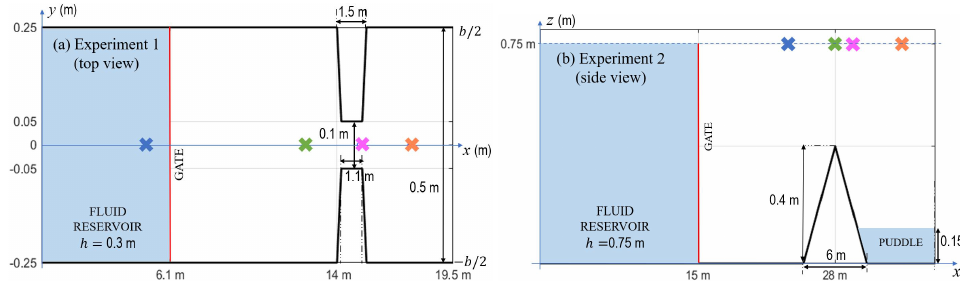
Figure 8. ( a ) Top view of the channel with a strong contraction used in experiment 1. ( b ) Side view of the channel with a triangular obstacle used in experiment 2. Locations of the four gauges along the channel are indicated by crosses: Gauge 1 (blue), Gauge 2 (green), Gauge 3 (magenta), and Gauge 4 (brown). In Figure 9d the sudden increase at water level happened after time t = 5 s.